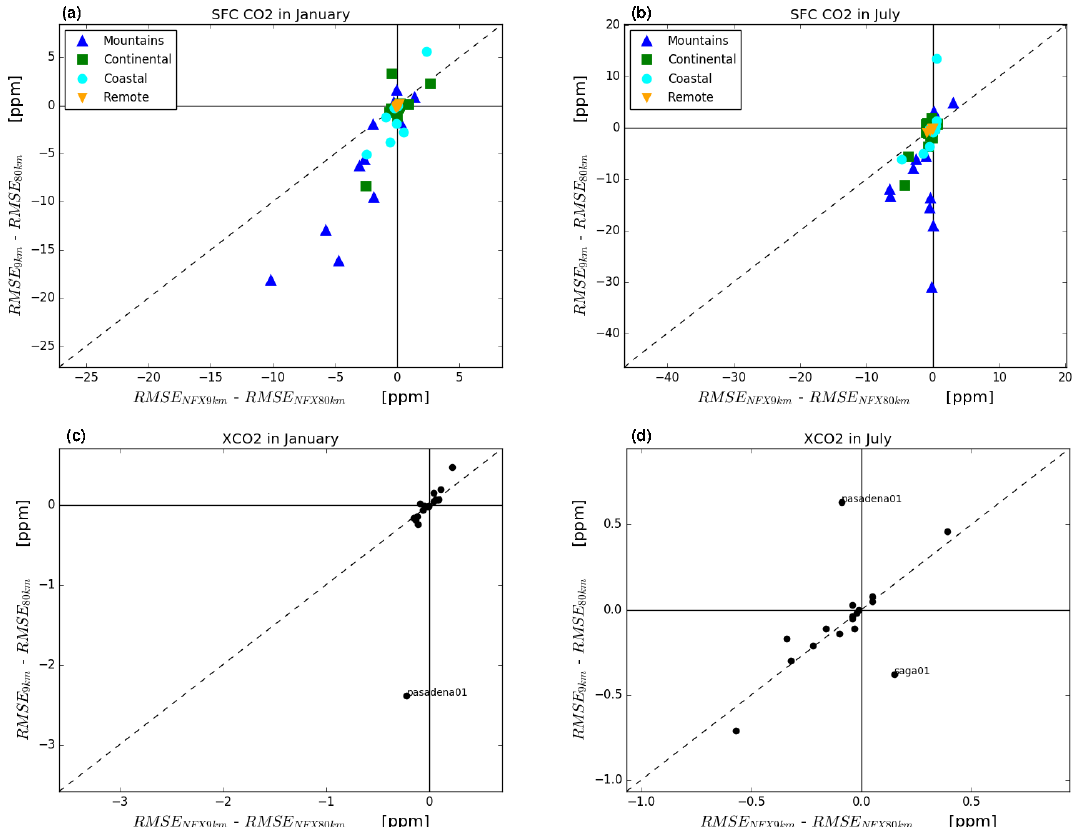
Figure 8. Sensitivity of horizontal resolution impact to surface CO 2 fluxes at (a, b) surface stations and (c, d) TCCON stations in January and July, as shown by the difference in RMSE between different CO 2 tracers, i.e. the standard tracer (RMSE 9km –RMSE 80km ) and the CO 2 tracer with just transport (RMSE NFX9km –RMSE NFX80km ) in the y axis and x axis respectively. The symbols that are close to the dashed line correspond to stations that have a small sensitivity to local fluxes, while at the stations associated with symbols that are located above/below the dashed line there is a negative/positive contribution of the local fluxes at high resolution. The further from the dashed line, the larger the contribution of the local fluxes. The stations located along the y axis are mainly impacted by local fluxes. The surface stations in (a, b) are depicted with different symbols depending on whether they are classified as mountain, continental, coastal or remote (see Table A1), while TCCON stations that are strongly influenced by fluxes are labelled with station names. Note that different scales are used in each